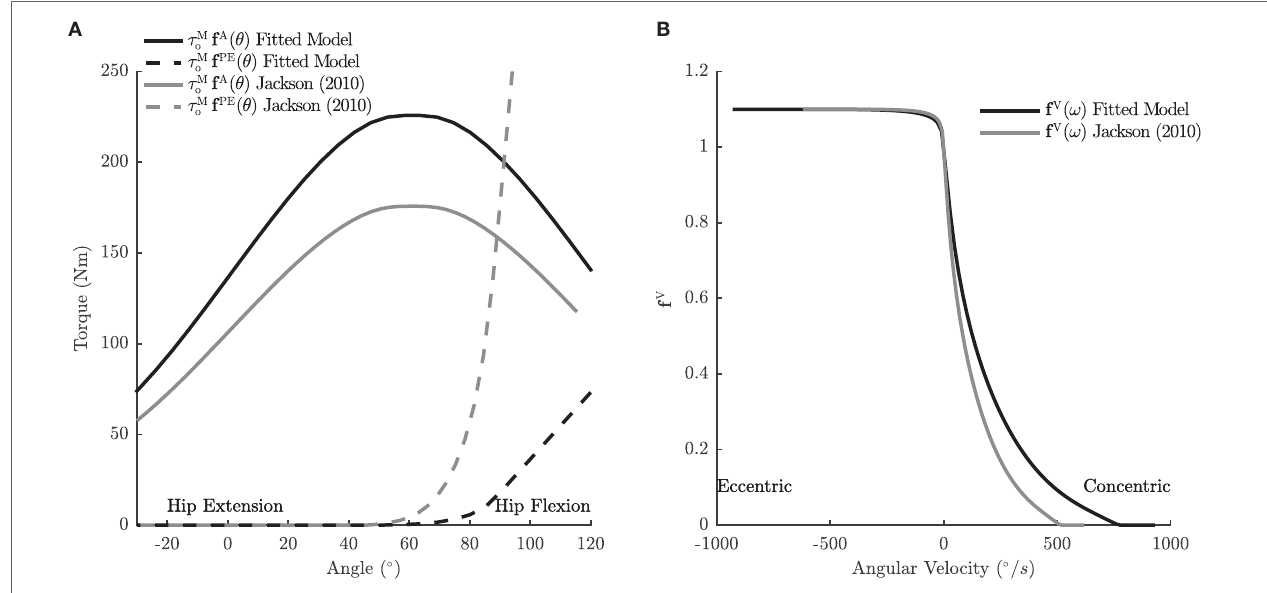
FIgURe 2 | The torque–angle (a) and torque–velocity (b) characteristics of the hip extensors, one of the 18 MTGs used in the sagittal-plane lifting model. Jackson’s original passive torque–angle curve was applied to simulate a vault, a motion that requires far less hip flexion than a stoop. Accordingly, we shifted the passive torque–angle curve of the hip extensors to accommodate the larger hip flexion angles during the stoop motion. In addition, the strength and torque–velocity curves have been edited so that the model is strong enough to perform the lift as the experimental subject